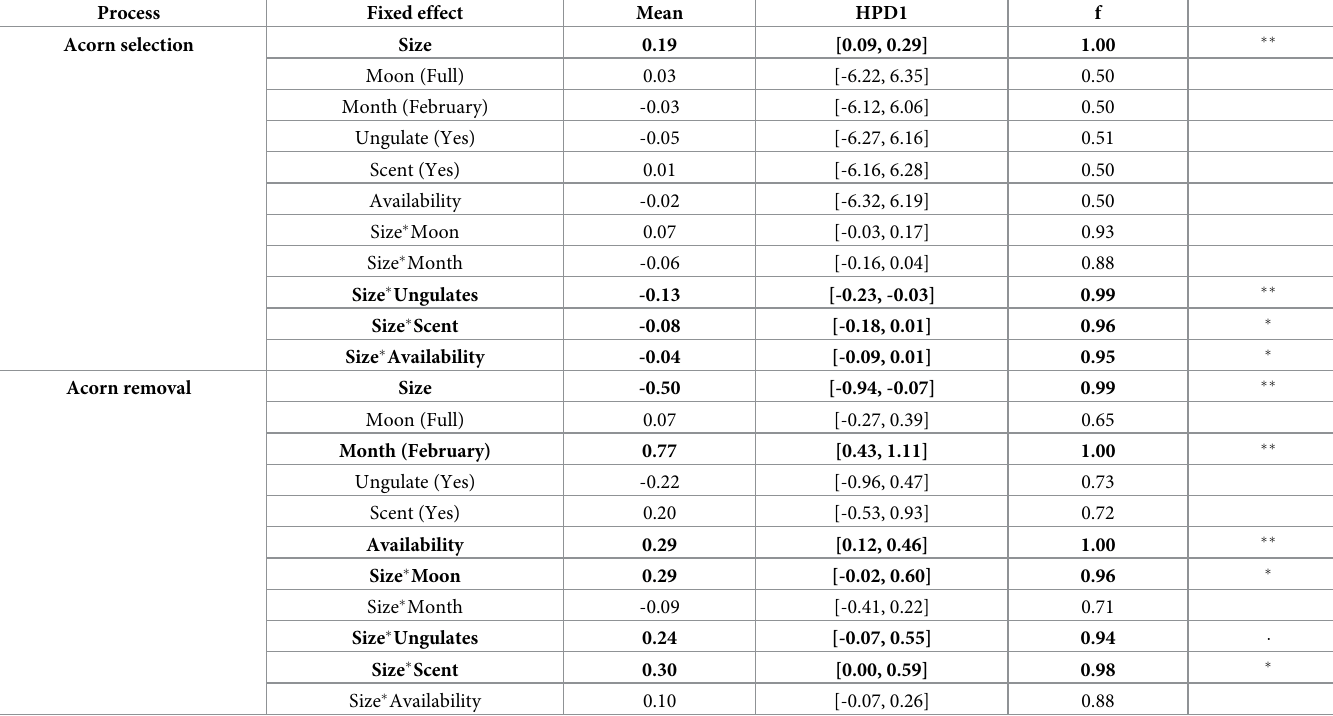
Table 1. Summary table of the effects of size, moonlight, month, ungulate presence, predator scent and local acorn availability (and their interactions with size) on the probability of acorn selection and removal. A total of 1677 foraging events were analyzed.